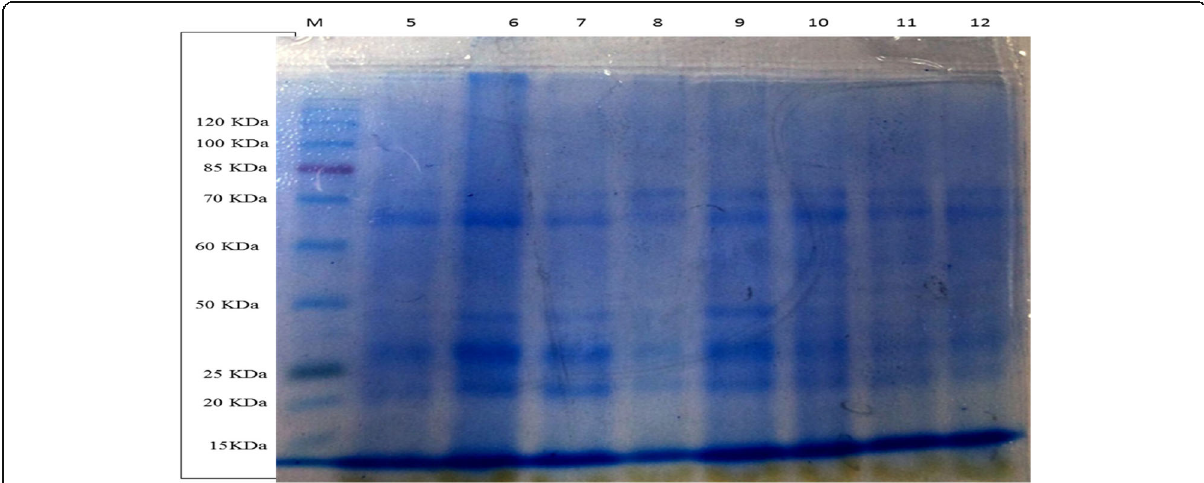
Fig. 5 Patterns of SDS-PAGE electrophoretic protein of E . grandiflorum plants as respond to leaser red and blue light irradiations for different time. For red light: 5. 5 min, 6. 10 min, 7. 20 min, 8. 25 min. For blue light: 9. 5 min, 10. 10 min, 11. 20 min, 12. 25 min and M. protein